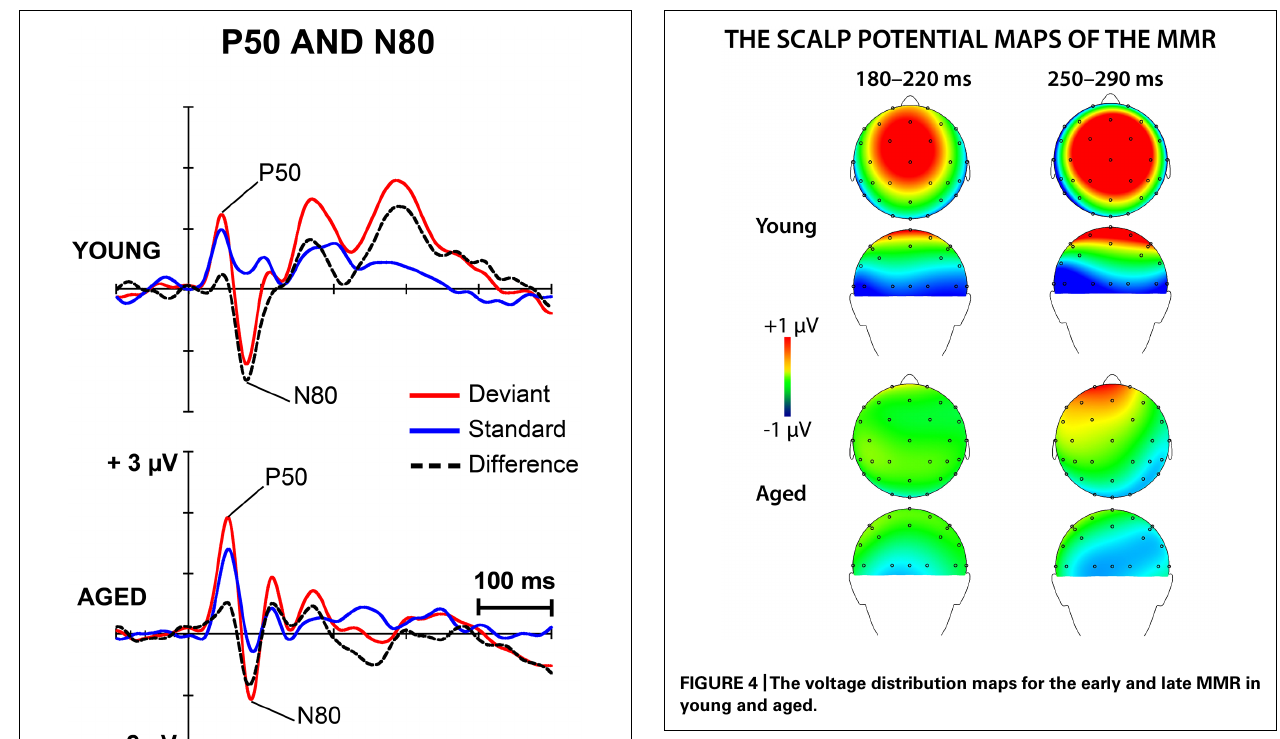
FIGURE 3 |The grand-averaged waveforms to deviant and standard stimuli and a differential waveform within each age group at electrode C4, where P50 and N80 were analyzed.